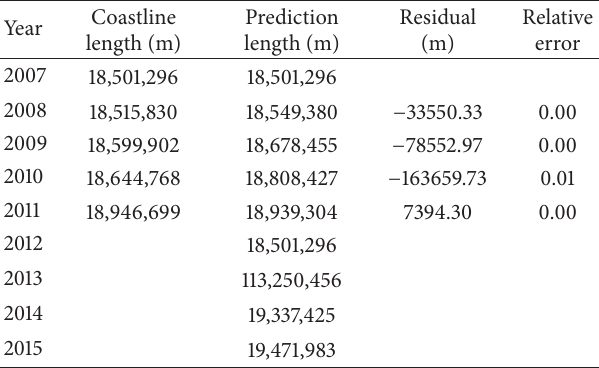
Table 4: China’s coastline length prediction